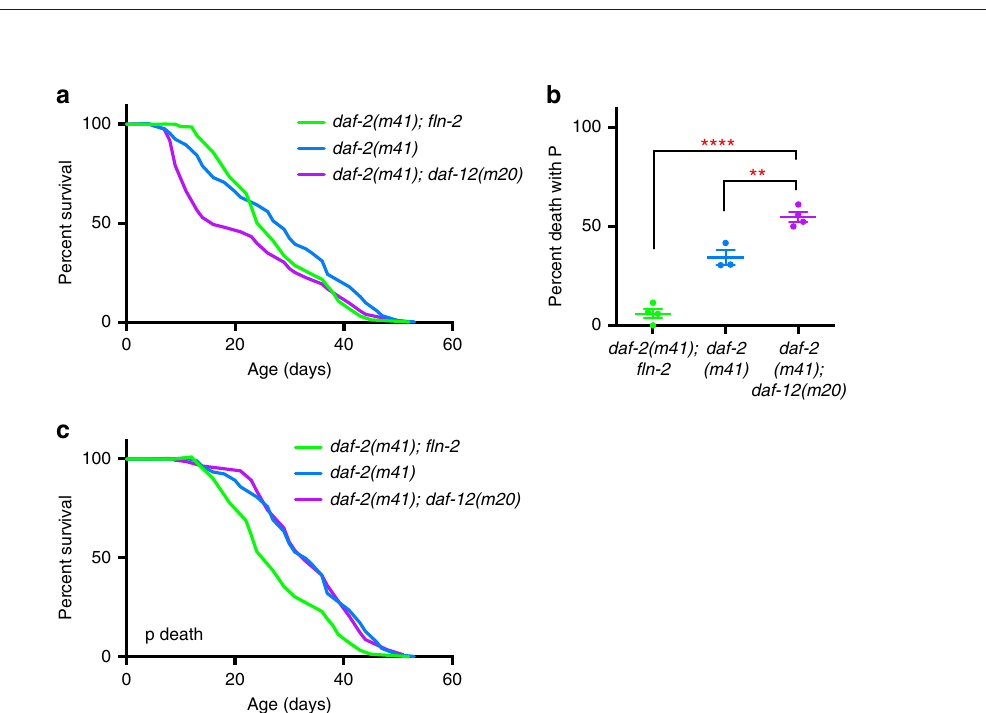
Fig. 3 Reduction of P death by fl n-2(ot611) masks effects of high copy number sir-2.1 over-expression (oe) on lifespan. a Lifespan and b necropsy analysis of sir-2.1(oe) and control strains used in previous studies. GA strains are indicated by solid lines: GA468 geIs3 sir-2.1(oe); fl n-2(ot611) (blue) and GA707 wuEx166; fl n-2(ot611) control (black). LG strains are indicated by dashed lines: LG394 geIs3 sir-2.1(oe) (blue) and LG398 geIs101 control (black). sir-2.1(oe) reduced P death and extended lifespan in LG strains but not GA strains, consistent with both previous, con fl icting studies 21,22 . Error bar represents s.e.m. of three trials. See Supplementary Table 4 for full statistics. See Supplementary data 1 for raw mortality data. Source data are provided as a Source Data fi le. c Lifespan and d necropsy analysis of sir-2.1(oe) and control strains after backcrossing four times with N2H. GA outcrossed in solid lines: GA1909 geIs3 sir- 2.1(oe) (blue) and GA1907 wuEx166 control (black); LG outcrossed in dashed lines: GA1913 geIs3 sir-2.1(oe) (blue) and GA1915 geIs101 control (black). sir-2.1 (oe) strains (blue) from both labs showed a reduced frequency of P death compared to control strains (black) in fl n-2( + ) background. See Supplementary Table 5 for full statistics. a – d Trials conducted in the presence of 10 μ M FUDR. See Supplementary data 1 for raw mortality data. e Lifespan and f necropsy analysis of backcrossed sir-2.1(oe) and control strains, with FUDR excluded. Colour coding as in ( c , d ). See Supplementary Table 7 for full statistics. See Supplementary data 1 for raw mortality data. g sir-2.1(oe) and 10 μ M FUDR interact to protect against progression of bacteria infection. Pharyngeal invasion and widespread infection were scored in worms fed RFP-expressing bacteria. Colour coding as in Fig. 1c. Mean of two trials, n = 16 – 20 per time point in